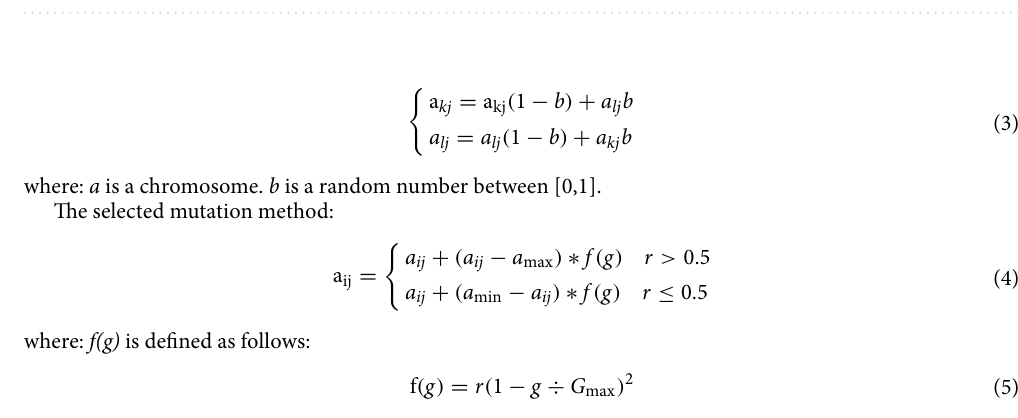
Figure 13. Comparison of prediction results and experimental results of dynamic stiffness under different